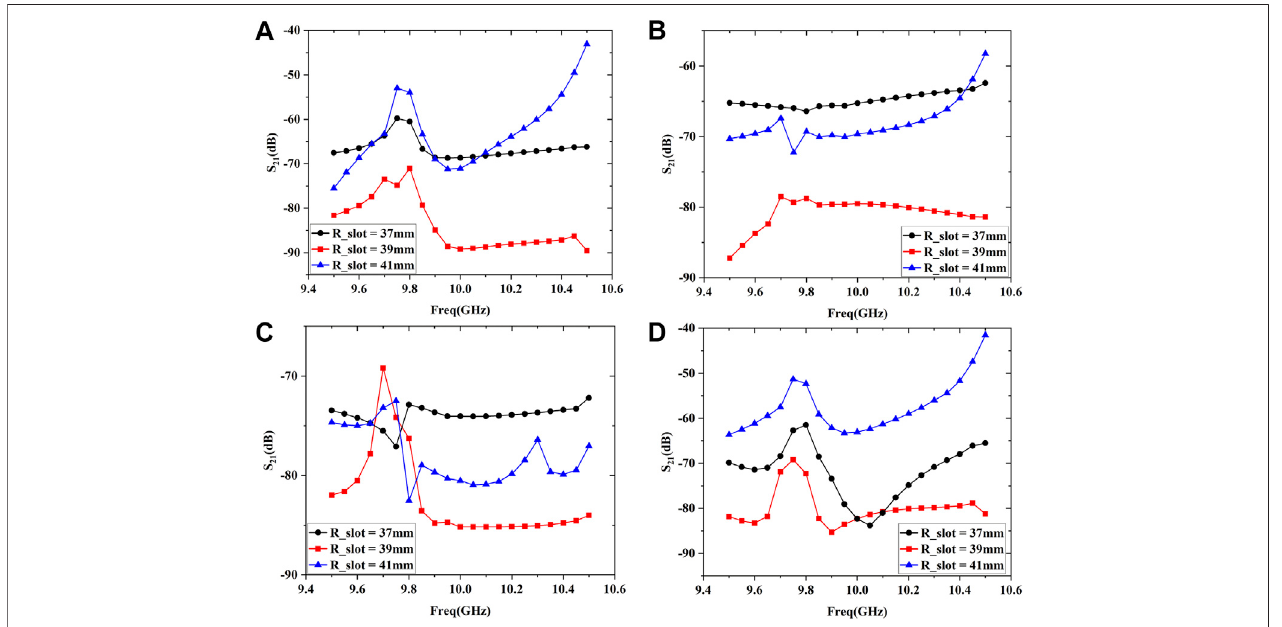
FIGURE 5 | In fl uence of radial slot radius on coupled mode transmission. (A) TE 11 mode. (B) TM 11 mode. (C) TE 31 mode. (D) Sum of TE 11 , TM 11 and TE 31 mode.